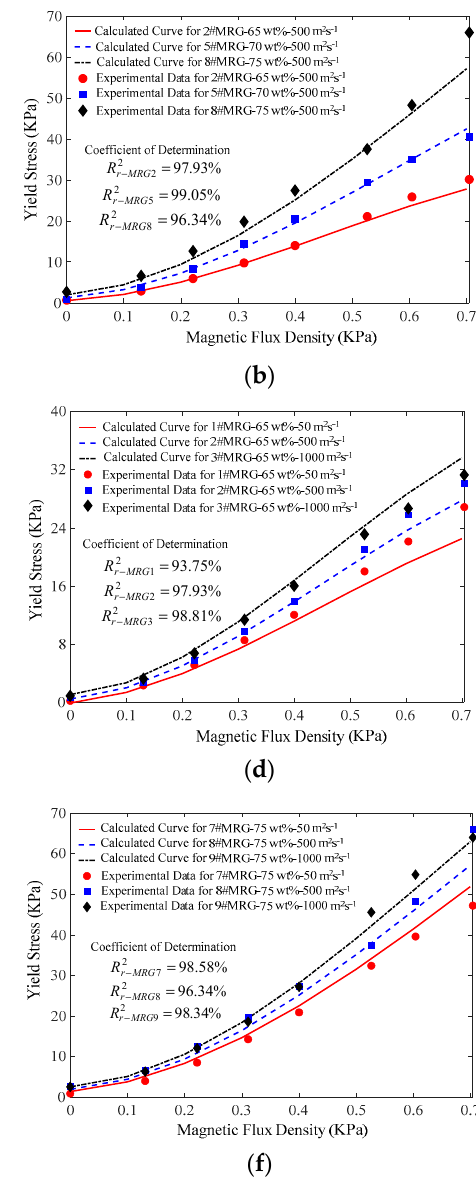
Figure 6. ( a ) Comparison of experimental and predicted yield stress by the proposed model for three samples with CIPs fraction in the range of 65–75 wt% and SOV at 50 m 2 ·s − 1 ; ( b ) Comparison of experimental and predicted yield stress by the proposed model for three samples with CIPs fraction in the range of 65–75 wt% and SOV at 500 m 2 ·s − 1 ; ( c ) Comparison of experimental and predicted yield stress by the proposed model for three samples with CIPs fraction in the range of 65–75 wt% and SOV at 1000 m 2 ·s − 1 ; ( d ) Comparison of experimental and predicted yield stress by the proposed model for three samples with SOV in the range of 50–1000 m 2 ·s − 1 and CIPs fraction at 65 wt%; ( e ) Comparison of experimental and predicted yield stress by the proposed model for three samples with SOV in the range of 50–1000 m 2 ·s − 1 and CIPs fraction at 70 wt%; ( f ) Comparison of experimental and predicted yield stress by the proposed model for three samples with SOV in the range of 50–1000 m 2 ·s − 1 and CIPs fraction at 75 wt%.